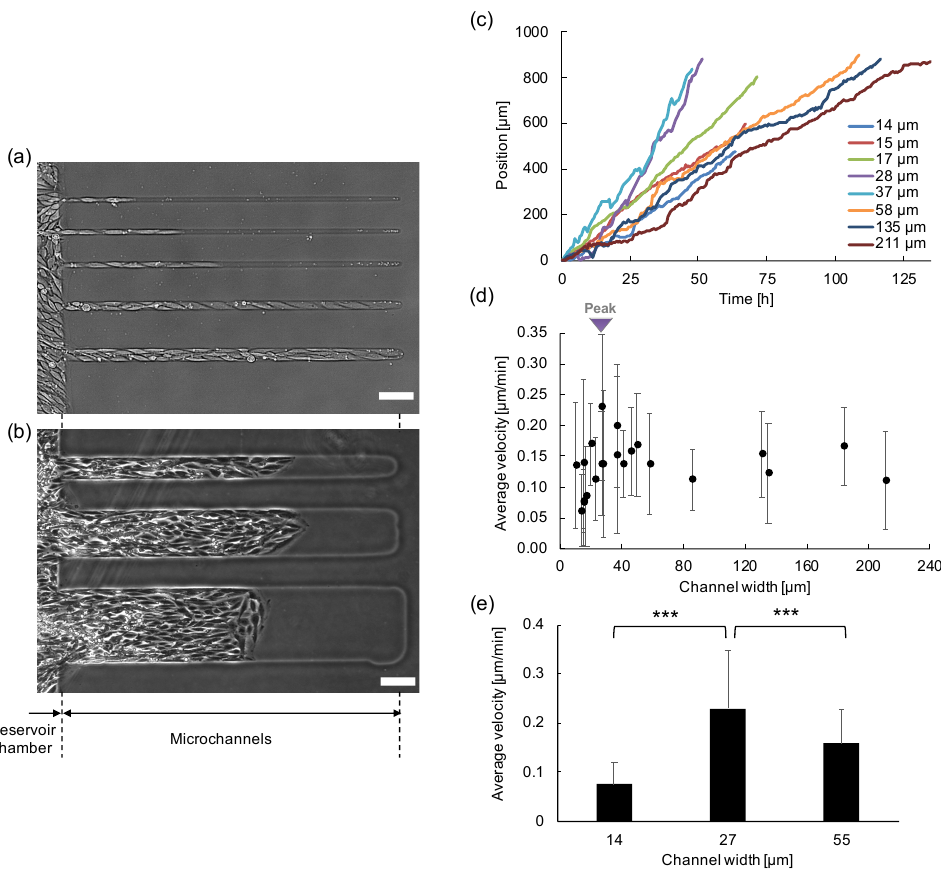
Figure 4. Collective cell migration in various width of agarose microchannels. ( a ) Micrograph of collective cell migration of MS-1 cells in 14.2, 15, 16.7, and 27.8µm width agarose microchannels, respectively (from top to bottom). ( b ) Micrograph of collective cell migration of MS-1 cells in 58.0, 135, and 211µm width agarose microchannels, respectively (from top to bottom). ( c ) Time course of collective cell migration in various widths of microchannels from 14µm to 211µm. The slopes represent the propagation velocity of their migrations. ( d ) Channel width dependence of migration velocity (mean ± S.D.). The peak velocity was observed around 30µm width microchannels (inverse triangle). ( e ) Significance test of narrower width (14µm), peak velocity width (27µm), and wider width (55µm) samples of ( d ). *** p < 0.001 unpaired Student’s t -test. Bars: